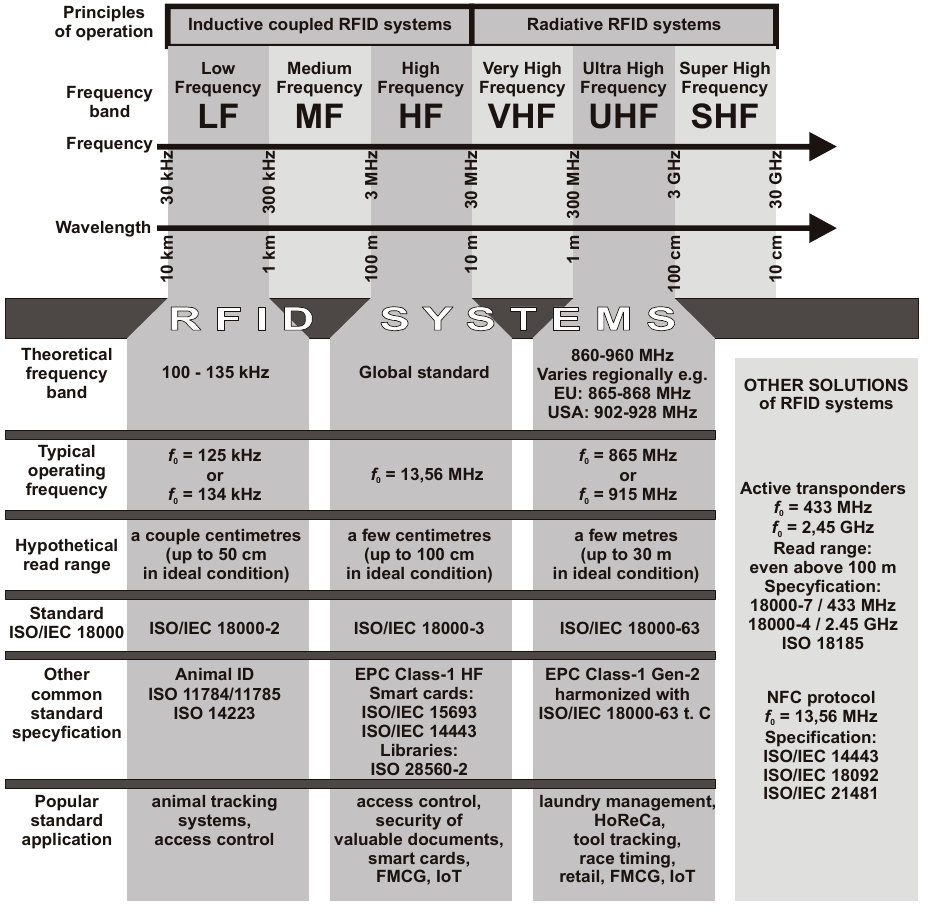
Figure 1. Basic information about RFID systems.